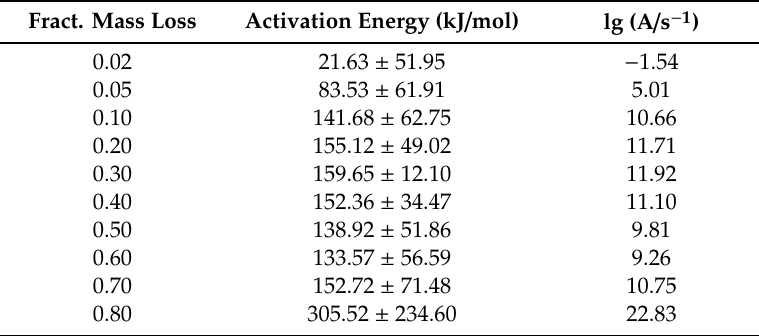
Table A2. Activation energy and pre-exponential coe ffi cient as a function of the degree of conversion by the Friedman method for an oat straw